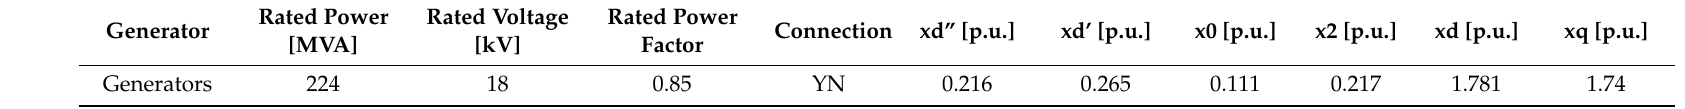
Table A4. Electrical parameters for the generators used in the STS.